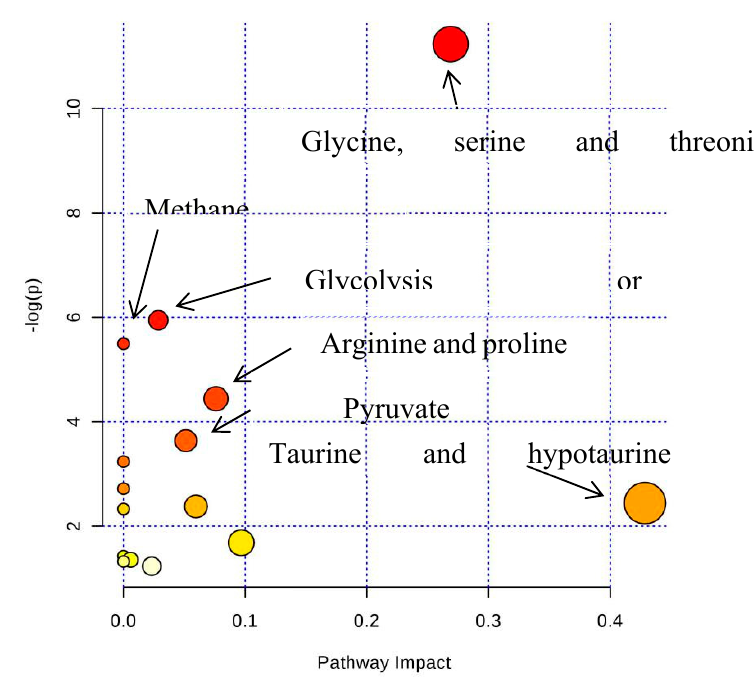
Figure 10. Pathway enrichment of differences metabolites between LPS and control groups.